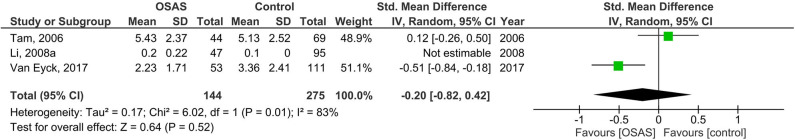
Forest plot of random-effects analysis of serum interleukin-6 levels in children. The diamond shape indicates the pooled mean difference (MD). Each black box represents a point estimate of each study and also gives a representation of the study size (the bigger the box, the more participants in the study). A horizontal line representing the 95% confidence intervals (CIs) of the study result, with each end of the line representing the boundaries of CI. SD, standard deviation; OSAS, obstructive sleep apnea syndrome.